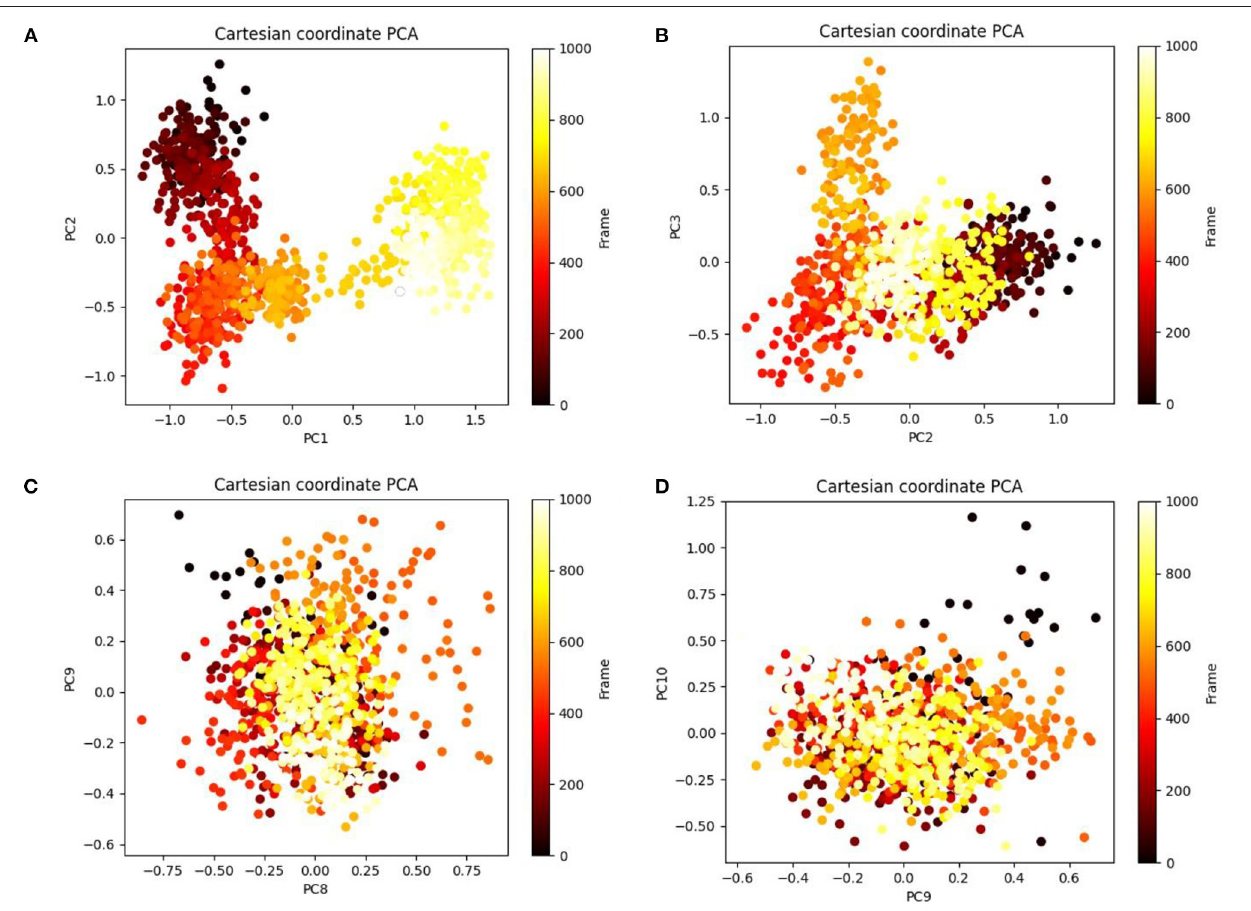
FIGURE 7 | Principal component analysis (PCA) of cinnamyl dihydrocinnamate (CMNPD5348) in complex with HDAC 2 displaying (A) PC1 and PC2, (B) PC2 and PC3, (C) PC8 and PC9, and (D) PC9 and PC10 for 100 ns simulation trajectories.